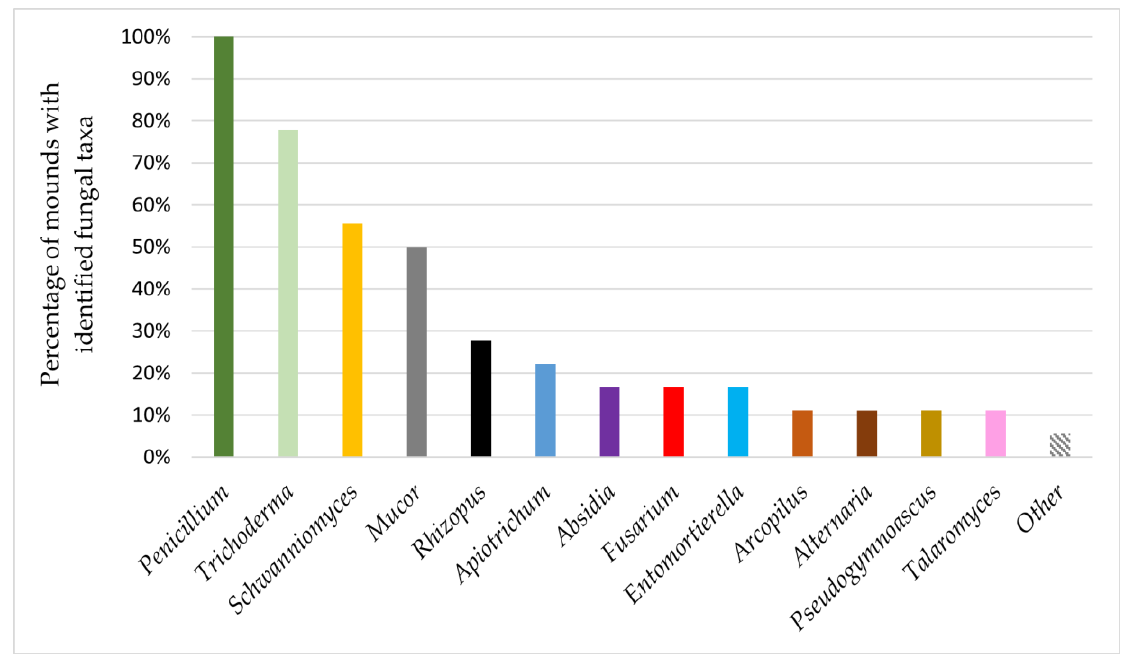
Figure 2. The presence of fungal taxa in F. polyctena